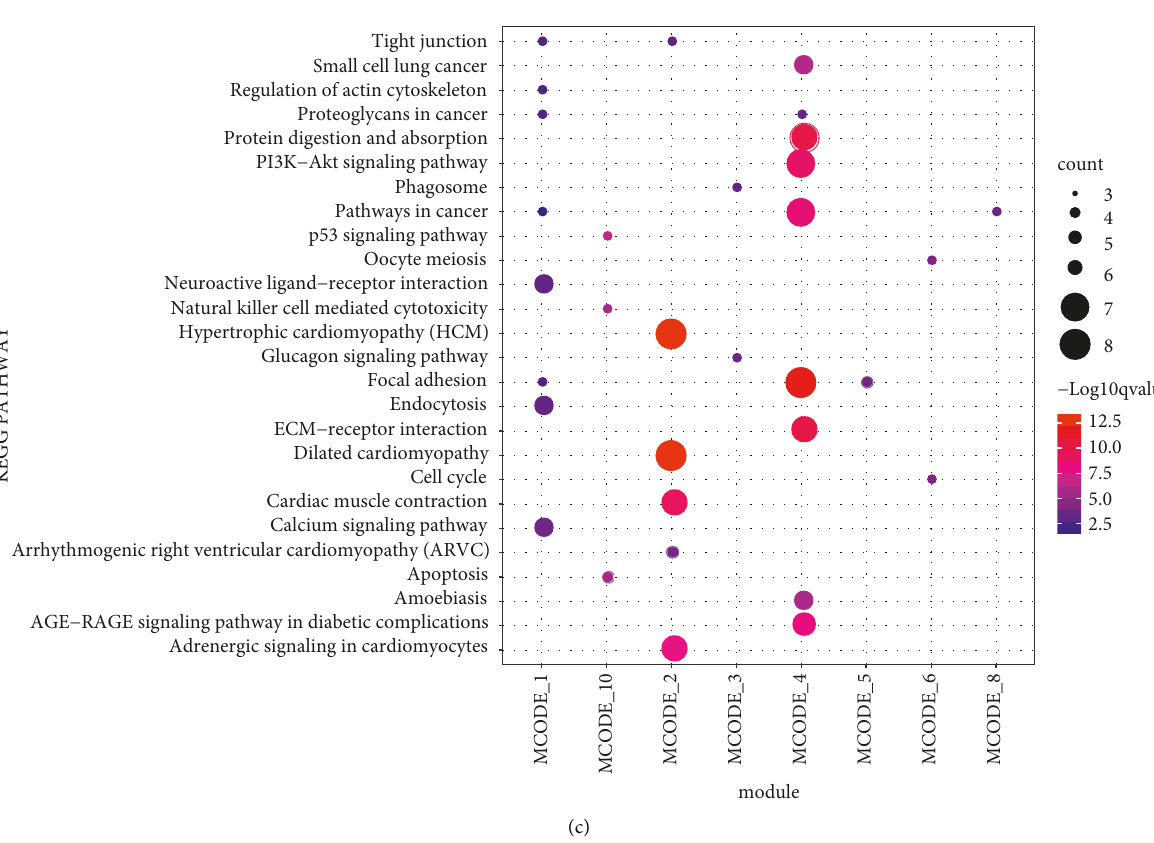
Figure 4: Construction of PPI network and module mining analysis. (a) PPI network analysis. (b) PPI network submodule. (c) Enrichment analysis results of the submodule KEGG pathway in the PPI